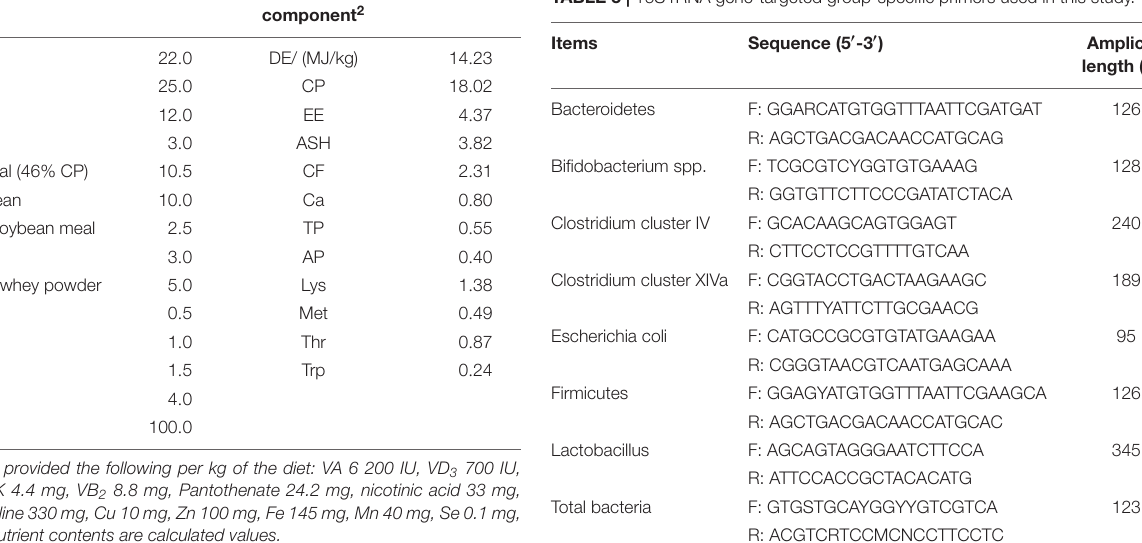
TABLE 3 | 16S rRNA gene-targeted group-specific primers used in this